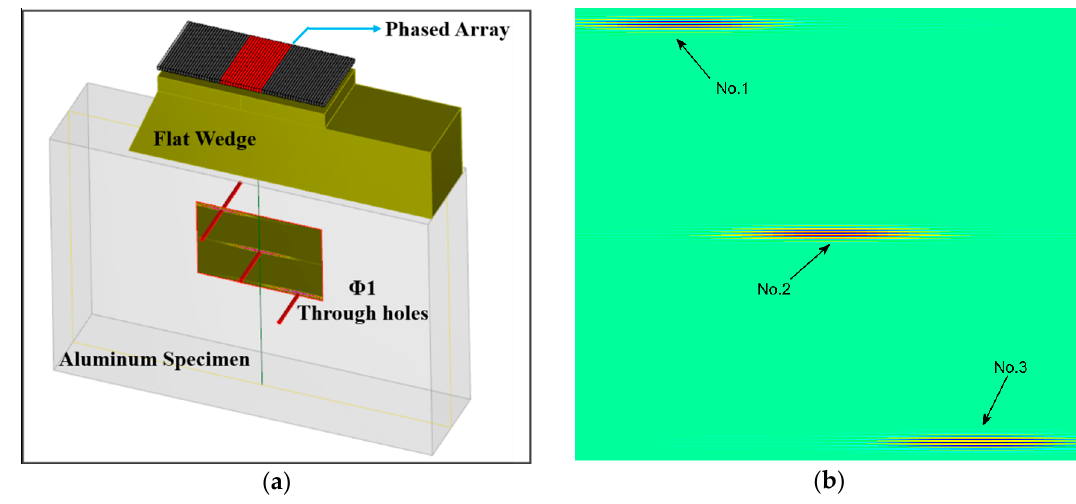
Figure 2. ( a ) The simulation setup using CIVA software; ( b ) the original image of 10 mm-space through holes. through holes. Table 1. Array parameters for simulation study. Table 1. Array parameters for simulation